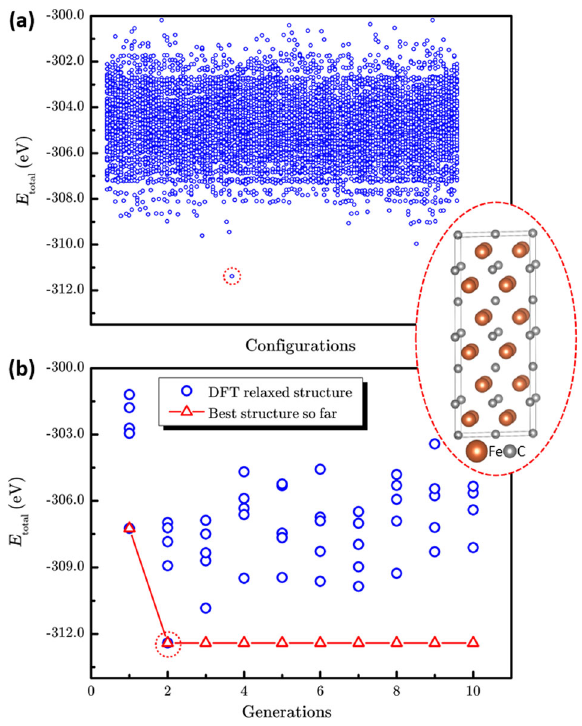
Fig. 3 The performance of enumeration method and LAsou method for ε -FeC x (x = 0.5). a The scatter plot of total energy of 10496 enumerated structures and the most stable structure, the DFT total energies are provided by Liu et al. 53 . b The searching process of LAsou method for the total DFT energy against with generation. Table 1. Performances (found the target structure or not in 10 generations) of ensemble, clustering, relaxation, and alternative ML model under LAsou method. The number in parentheses is the generation of fi nding the target structure.